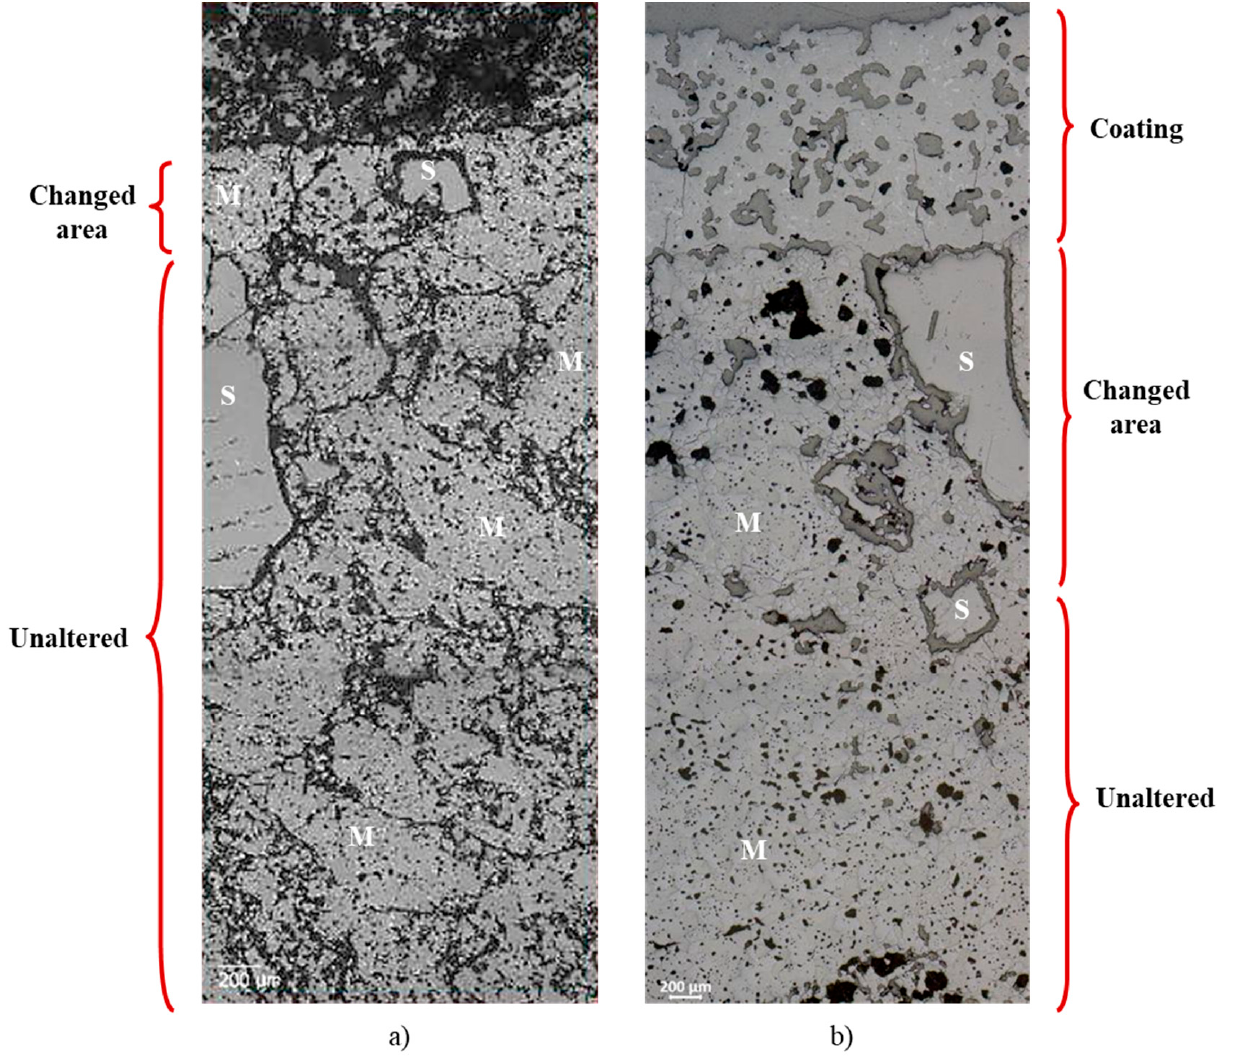
Figure 6. Microstructure of the clinker–brick interface of composition ( a ) A-1 ( b ) A-3 after the sandwich coating test (M = magnesia, S = fused spinel)—50× magnification.